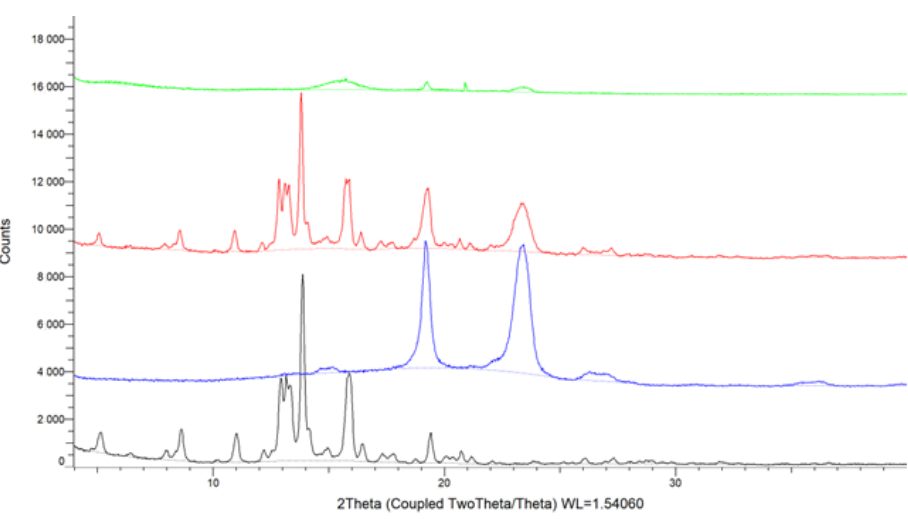
Figure 3. X-ray diffraction patterns of OA (black), Poloxamer 407 (blue), PM 1:1 (red), and SEM 1:1 (green).